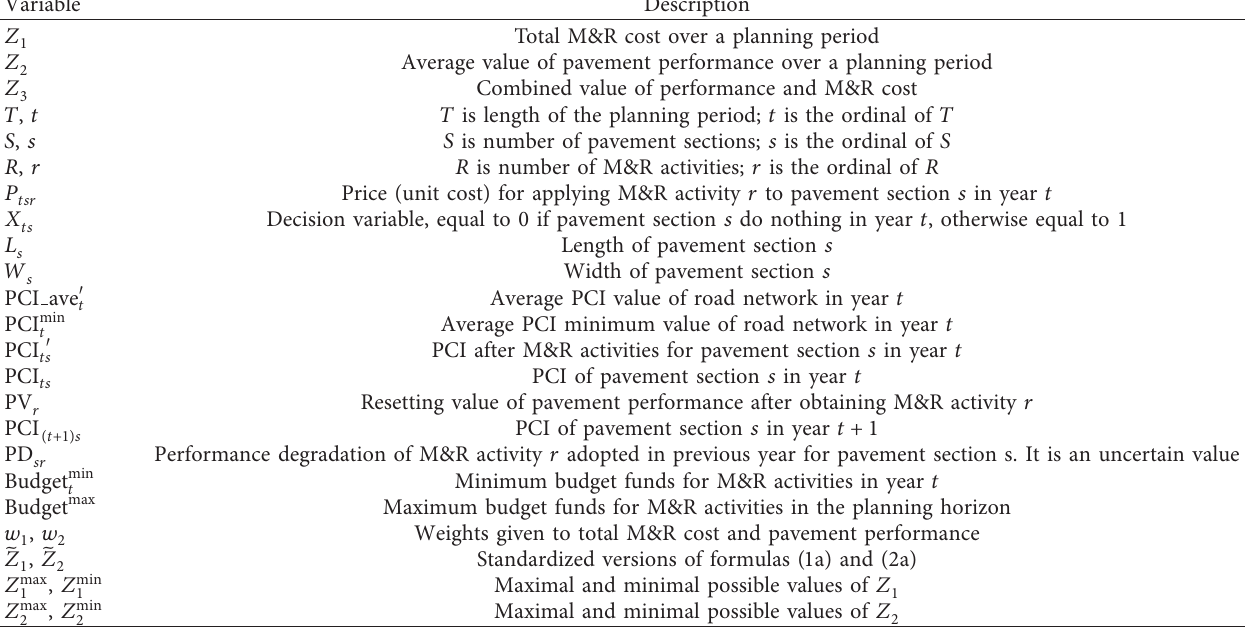
Table 1: Mathematical formulation